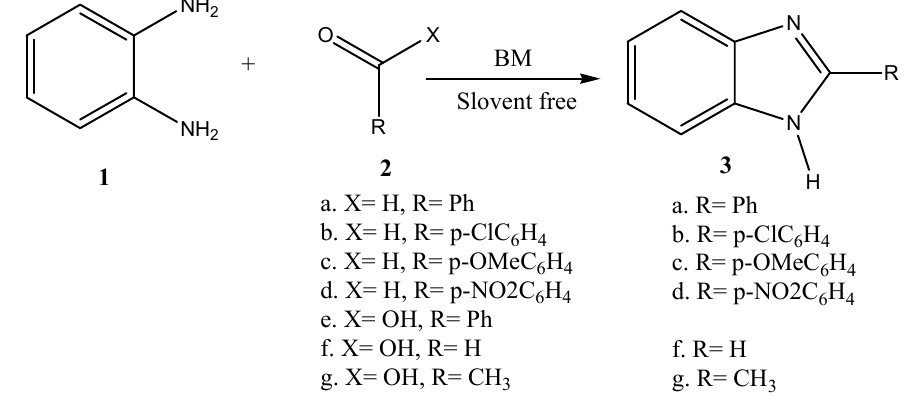
Scheme 1. Synthesis of various functionalized 2-substituted benzimidazole.